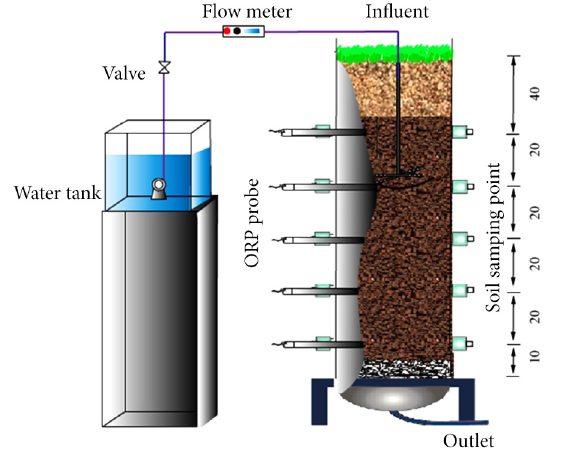
Figure 1. Experimental columns of subsurface wastewater infiltration system